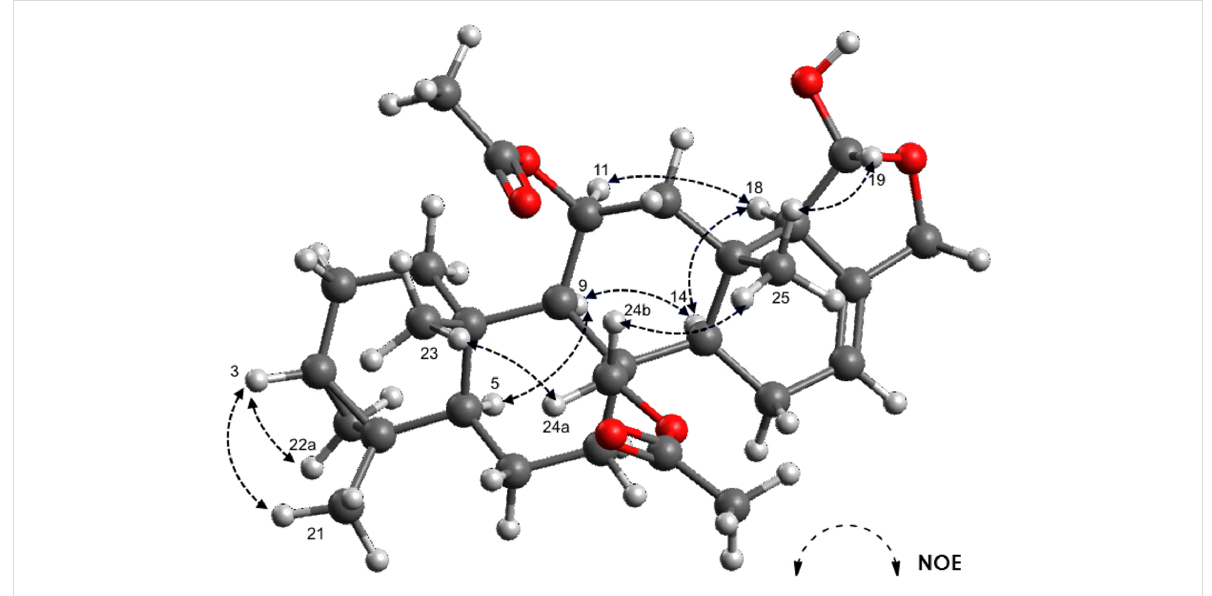
Figure 4: Proposed relative configuration of 12-deacetoxy-4-demethyl-11,24-diacetoxy-3,4-methylenedeoxoscalarin. Selected NOE correlations are indicated with arrows. The model was obtained using Avogadro, an open-source molecular builder and visualization tool, version